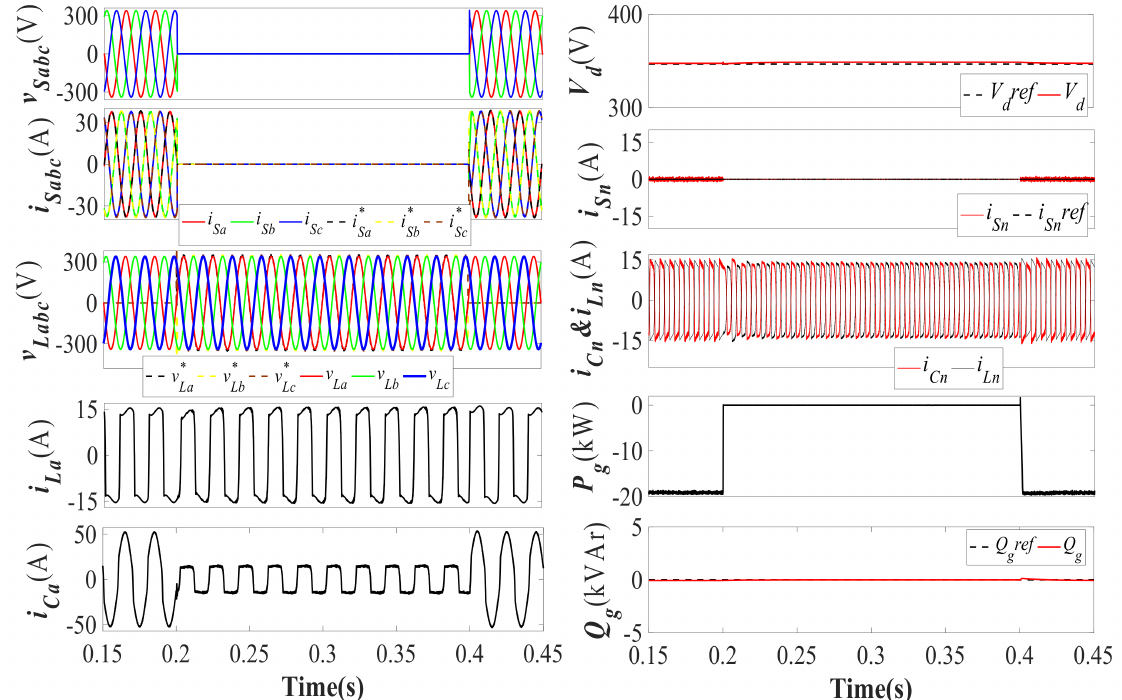
Figure 15. Dynamic performance during islanding and re-synchronization of v Sabc , i Sabc , v Labc i La , i Ca , V d , i Sn , i Cn , i Ln , P g , and Q g .